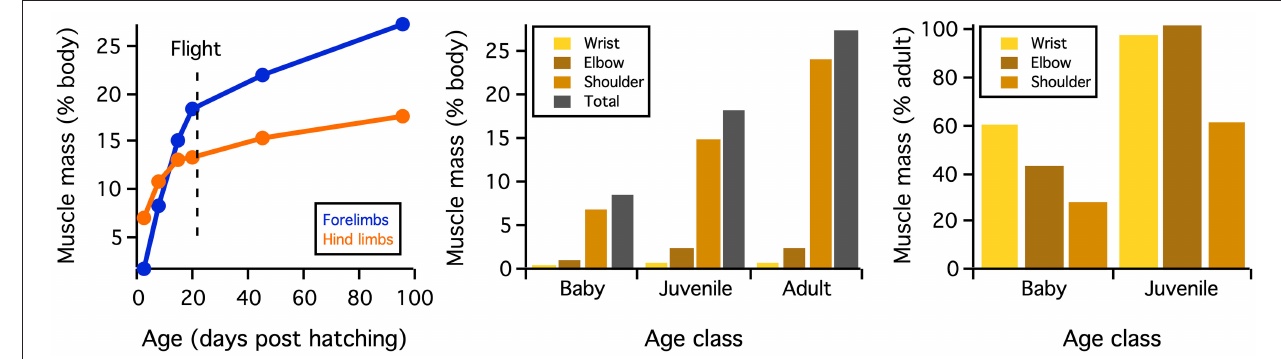
FIGURE 6 | Muscle mass. When standardized by body mass, muscle mass increases through ontogeny. These increases are most extreme for shoulder muscles that originate from the pectoral girdle ( Figure 3A ) and drive shoulder movements. Figure from Heers et al. (2018).